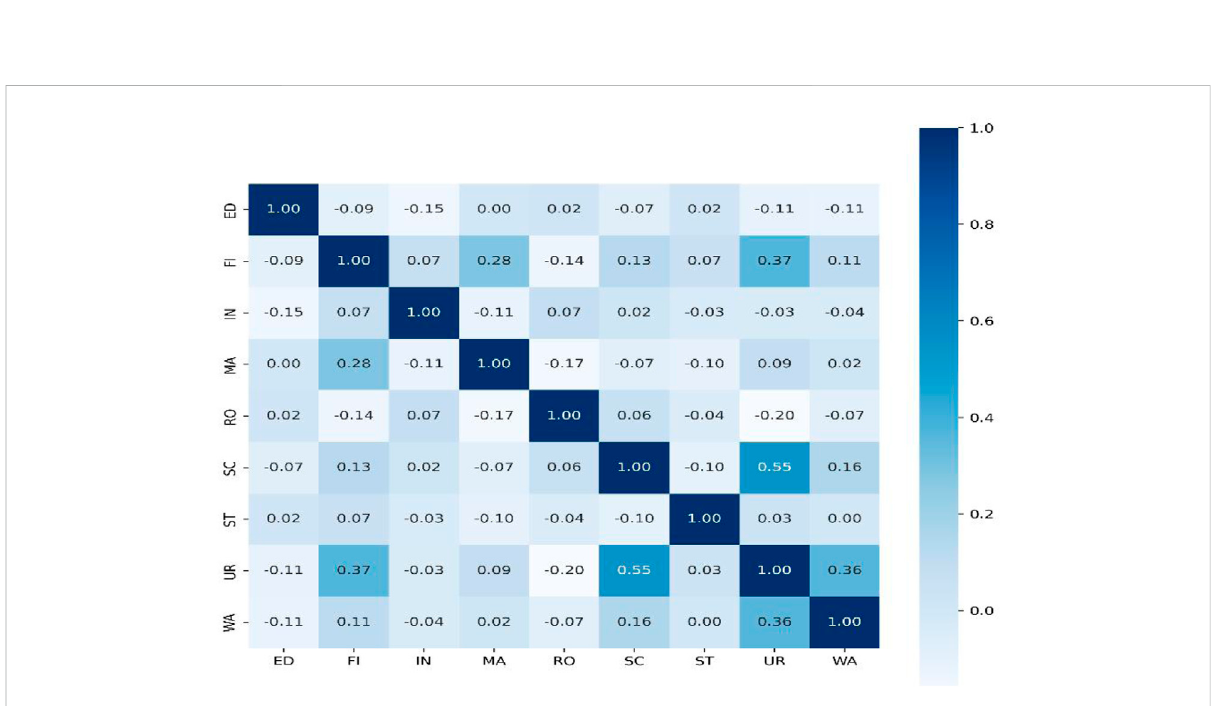
FIGURE 7 Heat map of correlation coef fi cients of driving